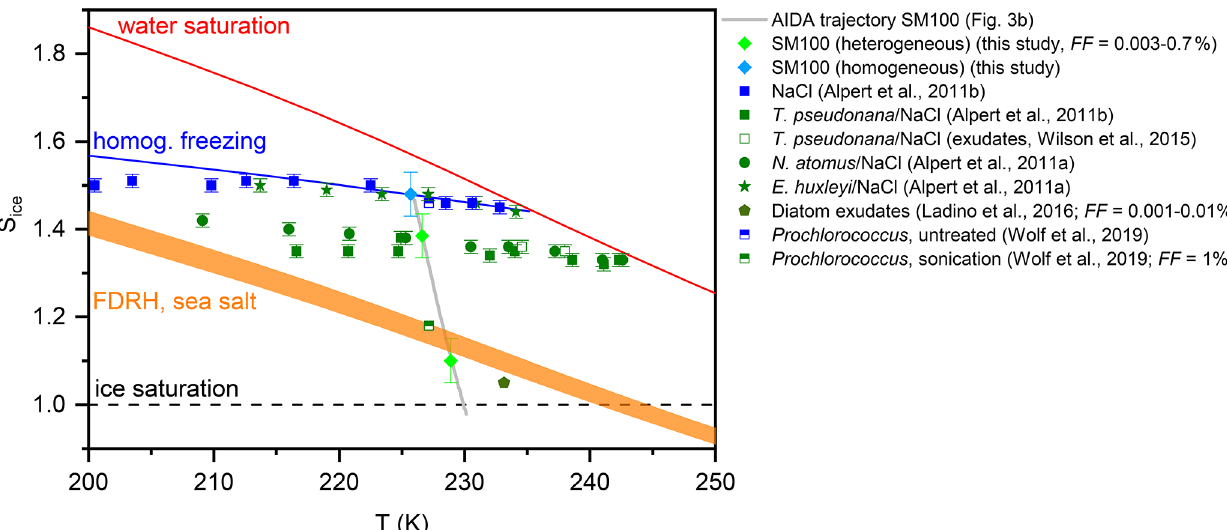
Figure 7. Homogenous and heterogeneous ice nucleation onsets from the AIDA expansion run with the particles generated from the SM100 culture shown in Fig. 3b (light green and blue diamonds) in comparison with data from previous experiments with phytoplankton and marine bacterial species (see Sect. 1.2). The onsets from the immersion freezing measurements with the technique by Alpert et al. (2011a) were evaluated at median freezing temperatures for homogeneous and heterogeneous ice nucleation. The heterogeneous ice nucleation onsets from the AIDA and the various CFDC experiments correspond to different FF values as indicated in the legend and discussed in Sect. 4.1. The S ice versus T trajectory of the AIDA experiment is shown as the grey line. The other reference lines are the same as shown in Fig.